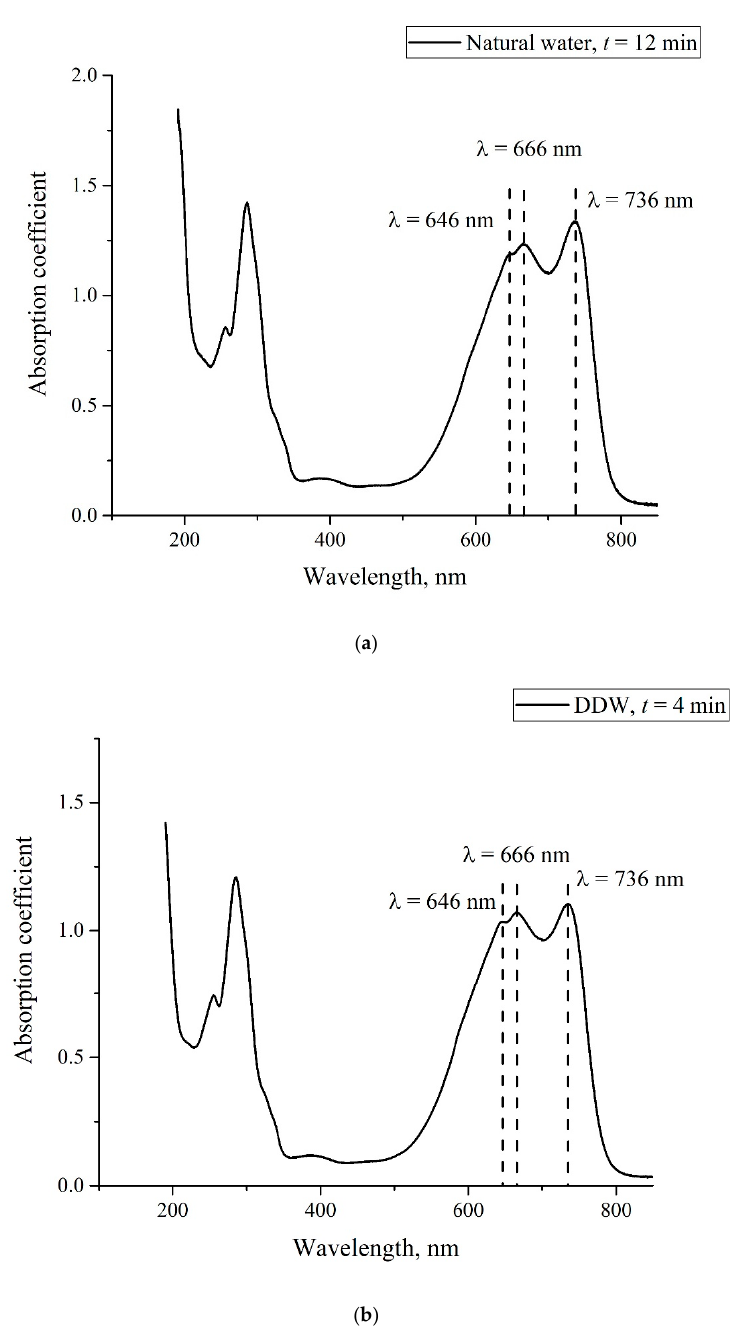
Figure 8. The triplet structures of the absorptivity spectra. Panel ( a )—the MB solution with con- centration 0.015 mg/mL is based on natural water, t = 12 min. Panel ( b )—the MB solution with concentration 0.015 mg/mL is based on DDW, t = 4